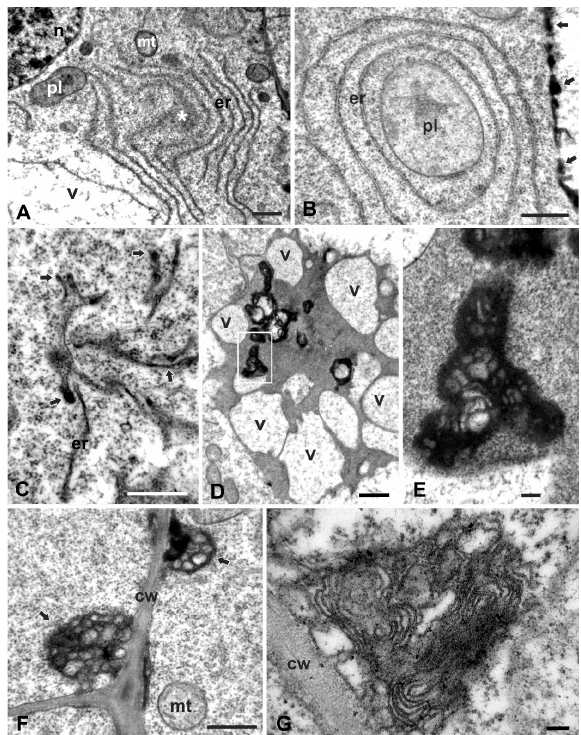
Figure 3. TEM micrographs illustrating the effects of 200 mg/L W for 12 h ( A ) or 24 h ( B – G ) on ER and on vesicular/lamellar conformations in cortex cells. Wavy bundle of endoplasmic reticulum (er) cisternae crossly or obliquely (asterisk) sectioned, close to a vacuole (v). pl = plastid, mt = mitochondrion, n = nucleus. ( B) . Concentric accumulation of ER (er) enclosing a plastid (pl) (enlargement of the outlined area in Figure 2). Arrows point to electron-dense material at the periphery of the nearby vacuole. C . Clustering of tubular elements with dense amorphous contents (arrows), contiguous with ER-like cisternae (er). ( D , E) . The central area of a cell containing several vacuoles (v) encircling amorphous material and electron-dense vesicular aggregations. Outlined area of Figure 3D is magnified in Figure 3E. ( F , G) . Multivesicular ( F , arrows) and multilamellar ( G ) bodies in contact with the cell wall (cw). mt = mitochondrion. Scale bars: A, B, C, F = 0.5 μ M; D = 1 μ M; E, G = 0.1 μ M.